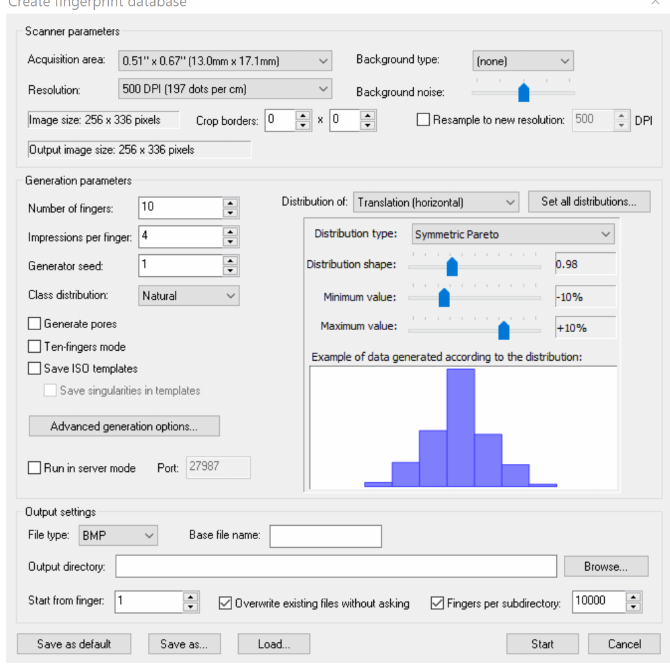
Figure 3. Sfinge: a software for the generation of synthetic